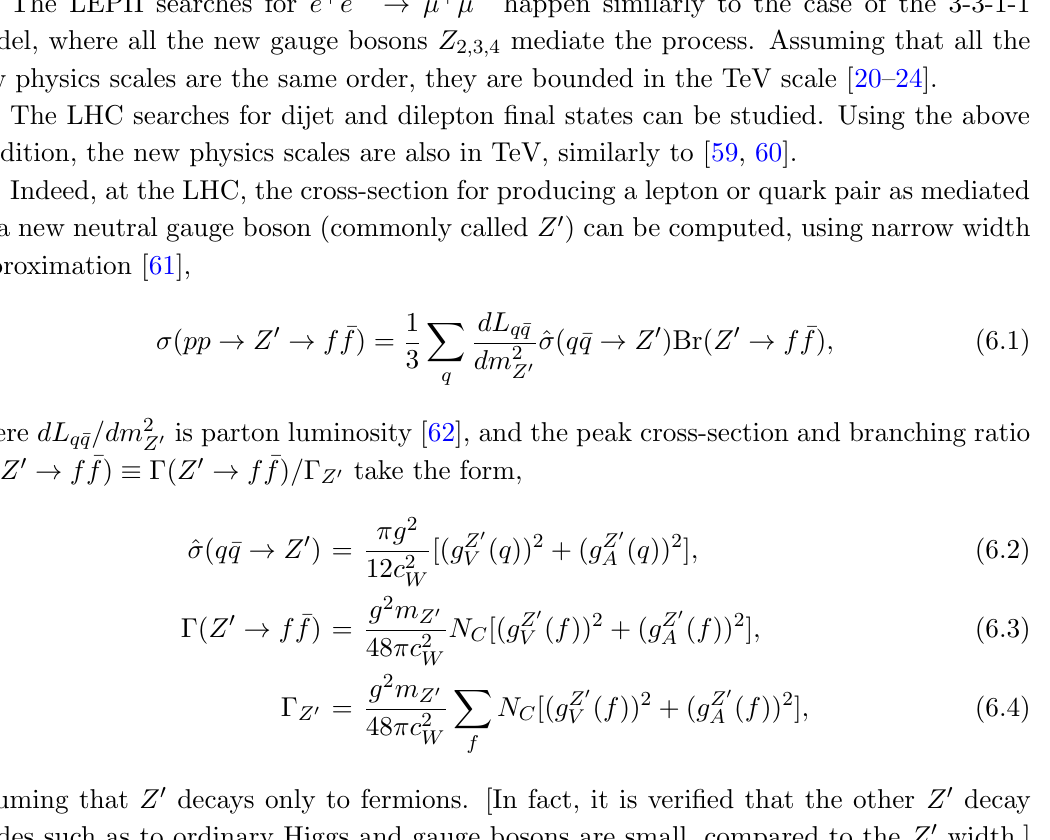
Figure 8 . The bounds on the new physics scales as functions of δ from the FCNCs for w = 0 . 5Λ V , where the panels from left to right and top to bottom are for the four dark matter models,